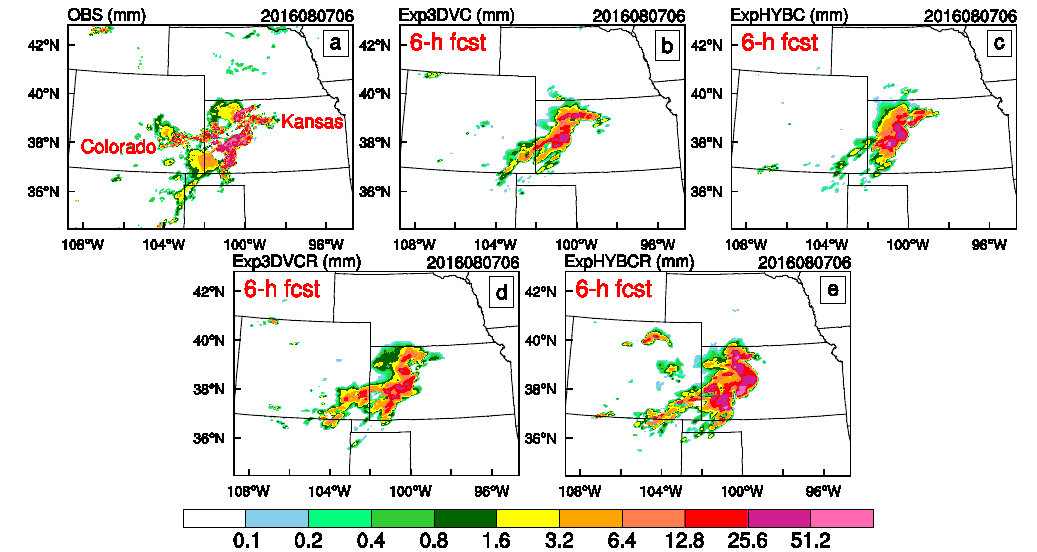
Figure 8. One-hour accumulated precipitation (unit: mm) of: observation ( a ); Exp3DVC ( b ); ExpHYBC ( c ); Exp3DVCR ( d ); and ExpHYBCR ( e ) of the convective system at 06:00 UTC on 7 August 2016 (initialized at 00:00 UTC on 7 August 2016).